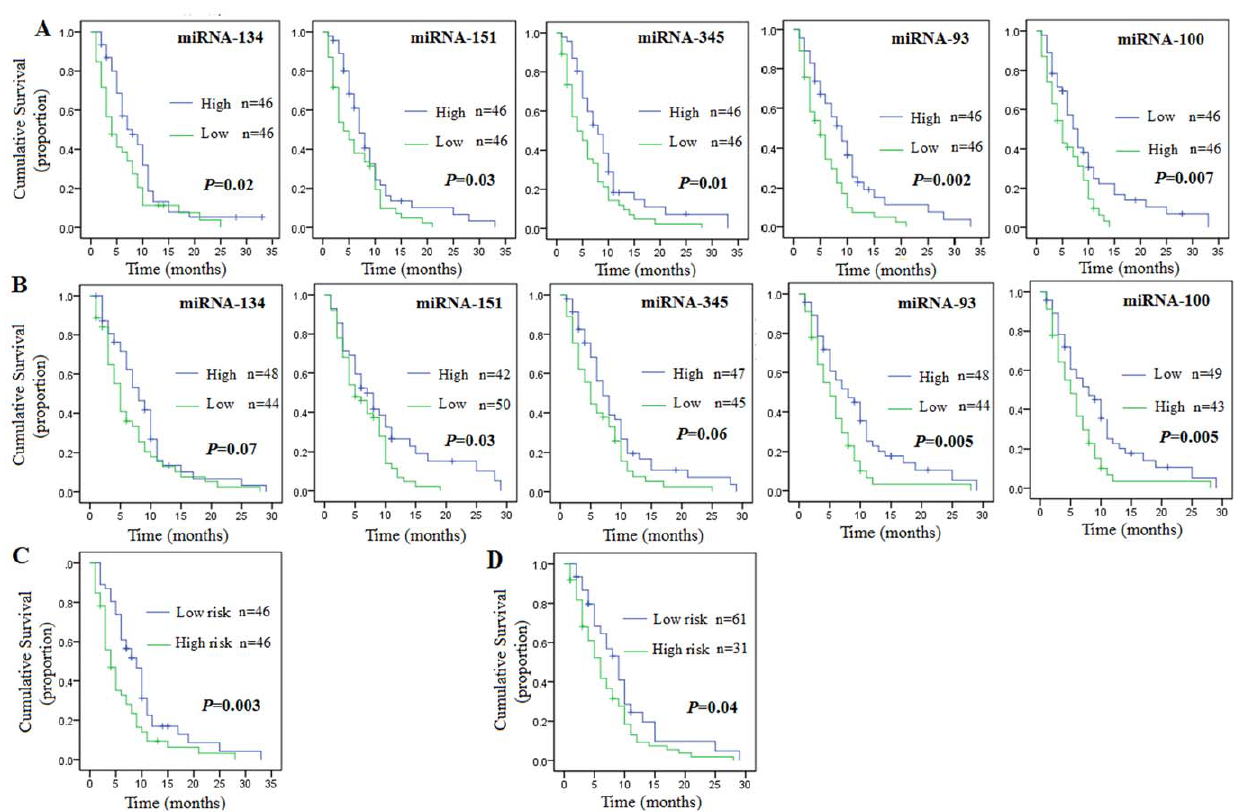
Figure 1. Kaplan-Meier survival estimates overall survival of lung cancer patients according to the miRNA expression signature. A) 92 patients in the training data set. B) 92 patients in the validation data set. C) Risk score and overall survival in training data set D) Risk score and